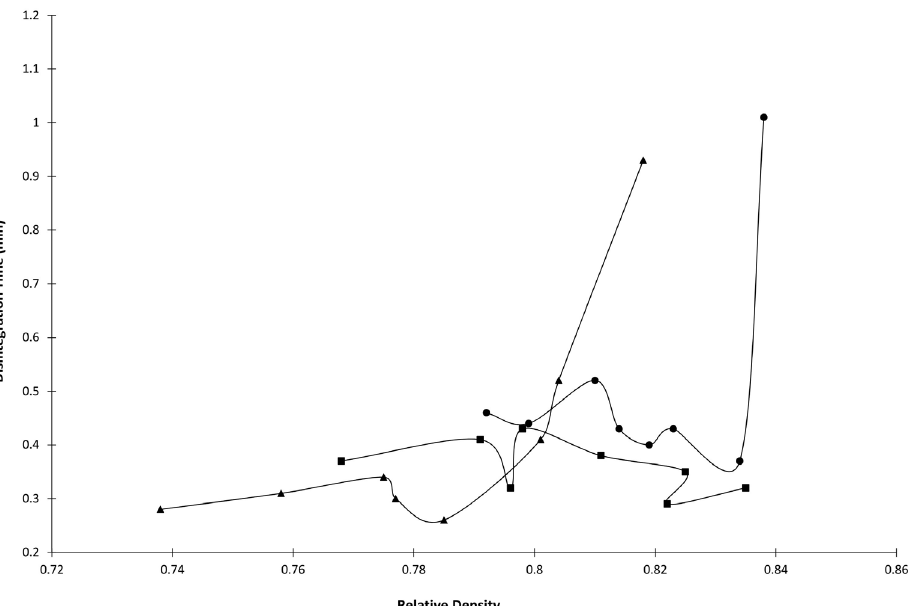
FIGURE 3 - Plots of Disintegration time against Relative density for paracetamol tablets containing 10% Endo Disintegrant of ▲ Native, ● Annealed, and ■ Succinylated Lima Bean